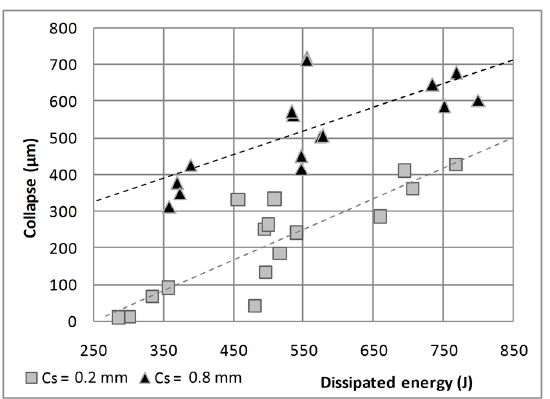
Figure 6. Collapse value as a function of the dissipated energy for 32 experiments.